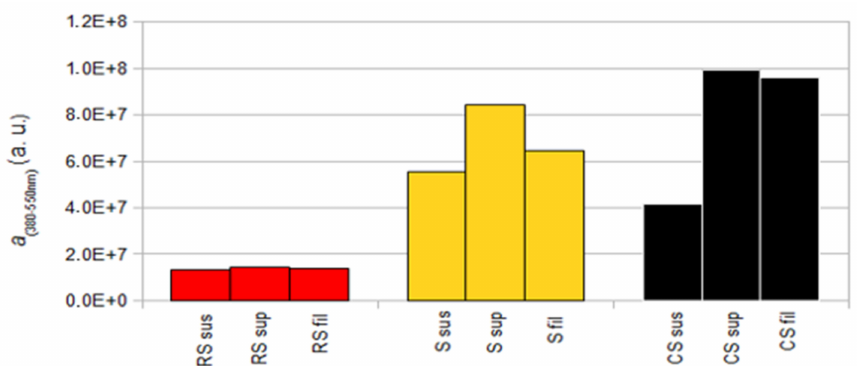
Figure 9. Value of the area below the emission curve between 380–550 nm for 5- [Mn II ] 2.9 @RSNP (5.5 × 10 − 7 mol/L) (RS—red), 5-[Mn II ] 3.9 @SNP (7.3 × 10 − 7 mol/L) (S—yellow) and 5-[Mn II ] 4.6 @CSNP (8.7 × 10 − 7 mol/L) (CS—black). sus: suspension; sup: supernatant; fil: filtrate. The exponent indicates the complex load in the nanoparticle.